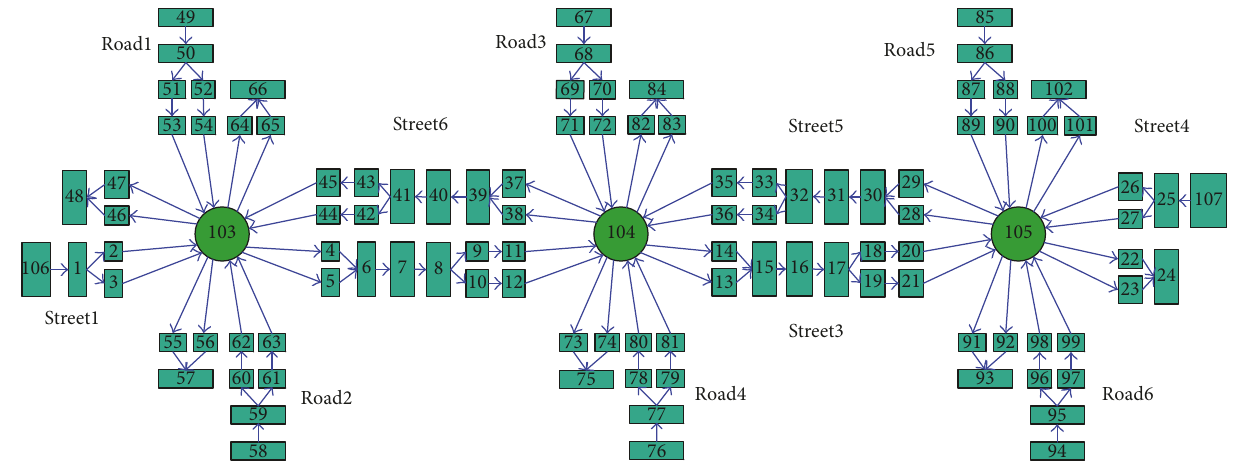
Figure 4: Multi-intersection simulation model based on Visual